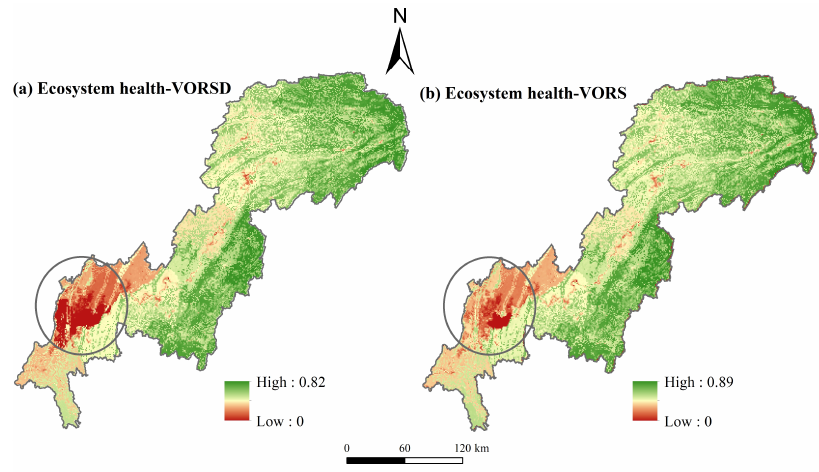
Figure 10. Spatial distribution of ecosystem health based on the VORSD model ( a ) and VORS model ( b ).